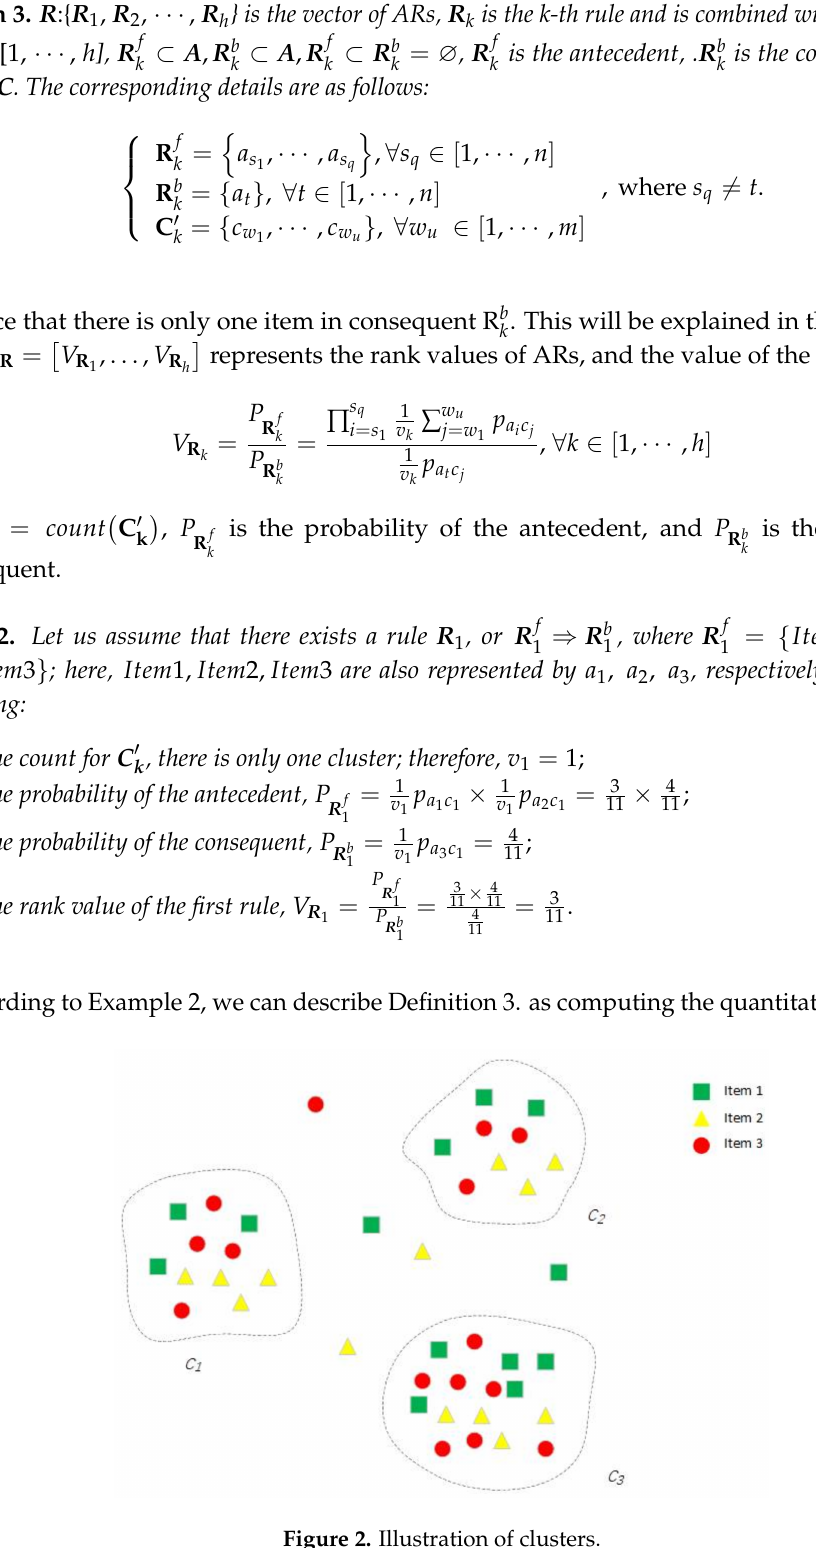
Figure 2. Illustration of